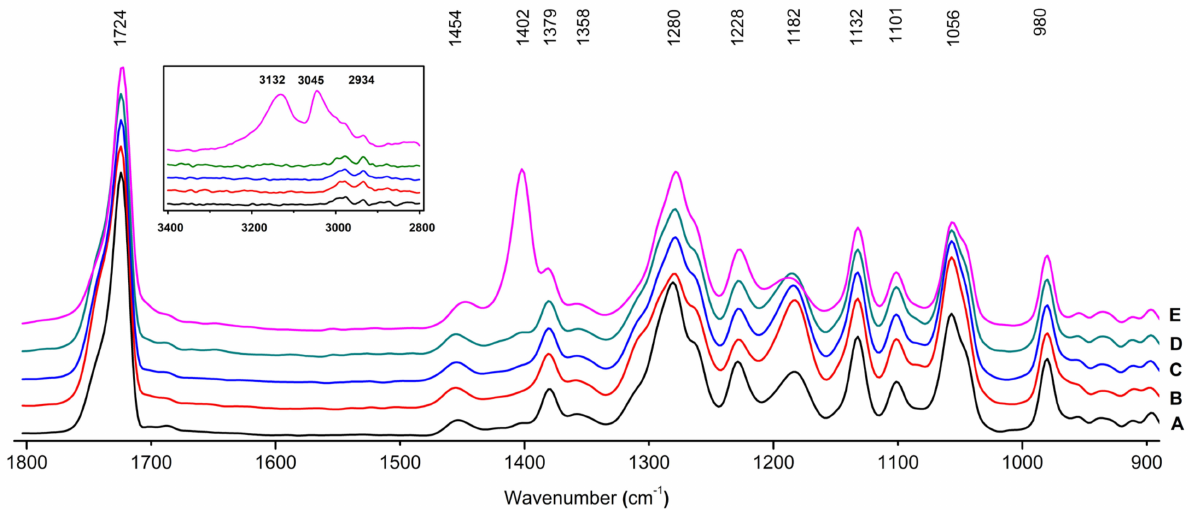
Figure 5. FTIR spectrum of PHB films before (A) and after UV radiation during 2 (B), 5 (C), 24 (D), 144 (E)